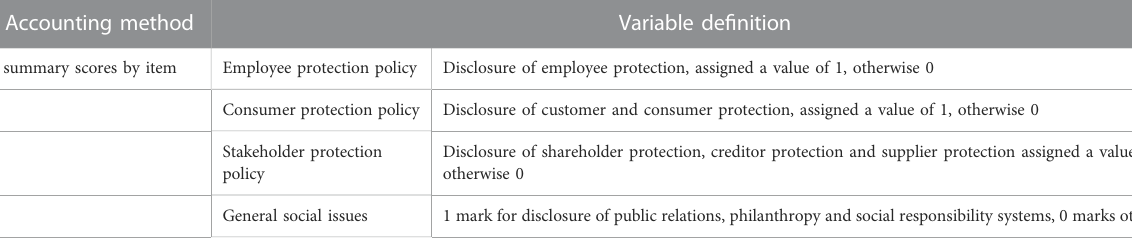
TABLE A2 De fi nitions of social responsibility performance variables.